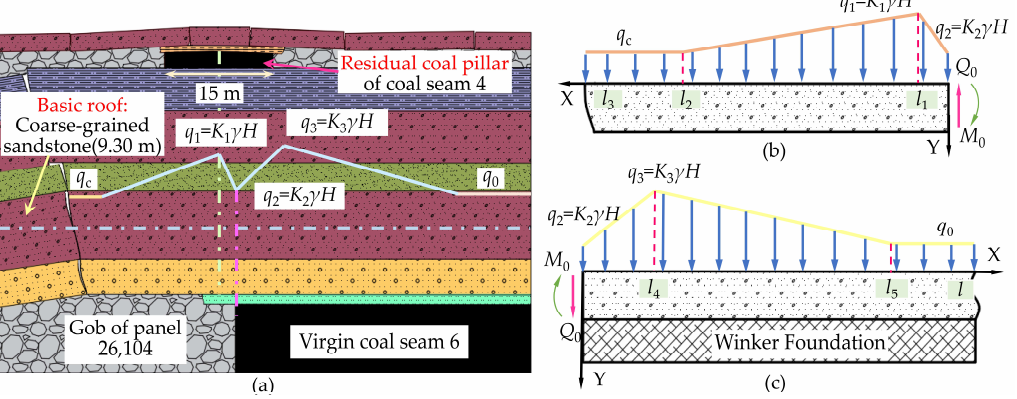
Figure 4. Mechanical model of elastic foundation beam. ( a ) Structural diagram before basic roof breaking. ( b ) Analysis of rock-beam of the overhanging part. ( c ) Analysis of rock-beam with the elastic